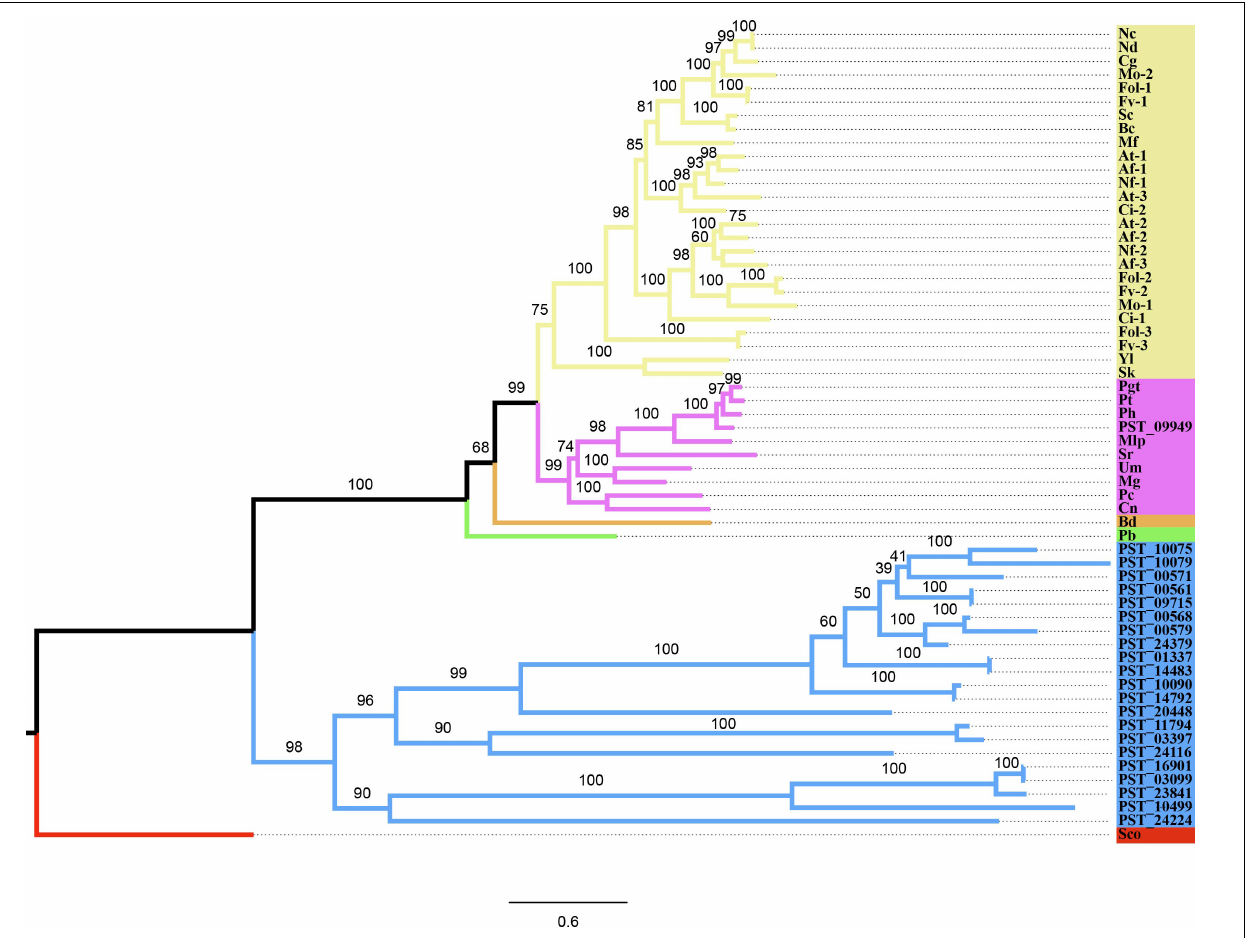
FIGURE 2 | Phylogenetic tree based on the CYP51 gene amino acid sequences of 26 fungal species in different phyla and predicted 22 genes in the CYP family of Puccinia striiformis f. sp. tritici ( Pst ) Spokes highlighted in blue present the CYP family of Pst ; spokes in green are Zygomycota; spokes in orange Chytridiomycota; spokes in purple Basidiomycota; spokes in yellow Ascomycota; and the outgroup Streptomyces coelicolor (Sco) is in red. The numbers around branch nodes were ultrafast bootstrap support. The corresponding relation for full names and abbreviations are showed as follows: Nc, Neurospora crassa ; Nd, Neurospora discreta ; Cg, Chaetomium globosum ; Mo, Magnaporthe oryzae ; Fol, Fusarium oxysporum f. sp. lycopersici ; Fv, Fusarium verticillioides ; Sc, Sclerotinia sclerotiorum ; Bc, Botrytis cinerea ; Mf, Mycosphaerella fijiensis ; At, Aspergillus terreus ; Af, Aspergillus flavus ; Nf, Neosartorya fischeri ; Ci, Coccidioides immitis ; Yl, Yarrowia lipolytica ; Sk, Saccharomyces kluyveri ; Pgt, Puccinia graminis f. sp. tritici ; Pt, Puccinia triticina ; Ph, Puccinia horiana ; Mlp, Melampsora larici-populina ; Sr, Sporobolomyces roseus ; Um, Ustilago maydis ; Mg, Malassezia globosa ; Pc, Phanerochaete chrysosporium ; Cn, Cryptococcus neoformans var. Neoformans ; Bd, Batrachochytrium dendrobatidis ; Pb, Phycomyces